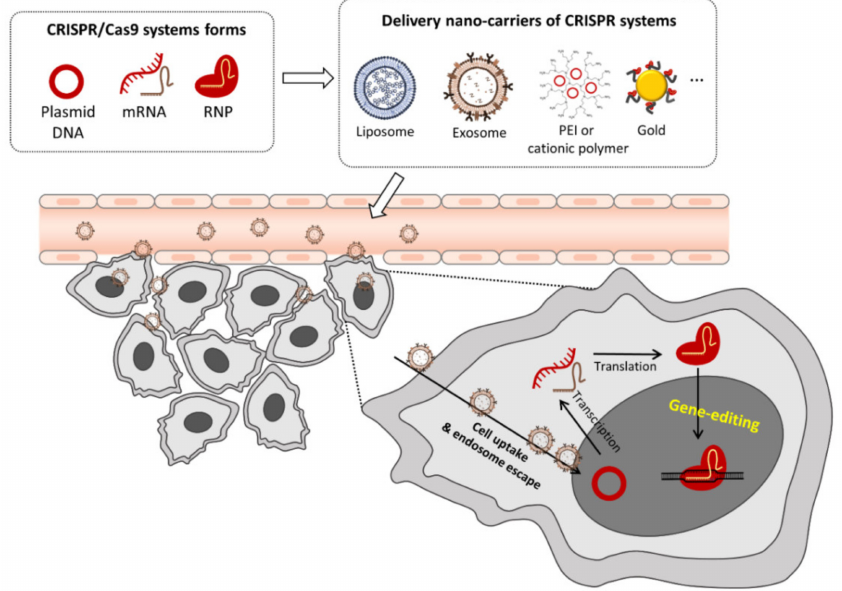
Figure 1. The cell delivery pathway of CRISPR/Cas9 encapsulated-nanoparticles. The CRISPR systems can be applied for gene therapy with non-viral carriers in three forms that include: plas- mid DNA (Cas9/sgRNA plasmid), in vitro transcribed Cas9 mRNA/sgRNA, and pre-assembled ribonucleoprotein (RNP) complex. Such nanoparticles can take several forms, including PEGylated- or cationic lipid-NPs (liposome), cell-mediated exosome, cationic polymers (polyethyleneimine, PEI; protamine, PA), and cationic lipid- or polymer-coated gold NPs. The plasmid DNA, mRNA and RNP of NPs may enter the cell via endocytosis and endosome escape, processing the RNP expression and gene